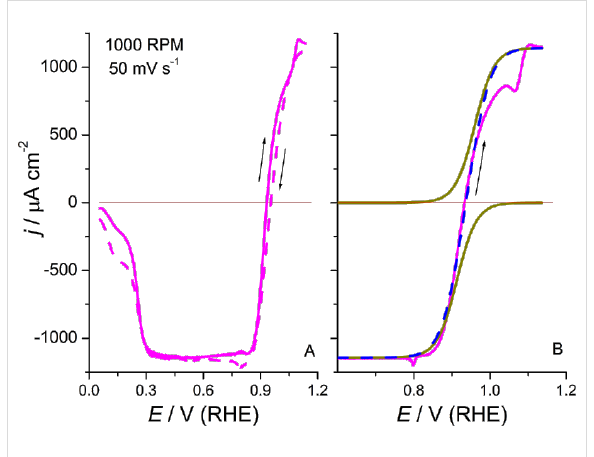
Figure 9: Hydrogen peroxide reduction and oxidation reactions on Pt(111) in 0.1 M HClO 4 + 1 mM H 2 O 2 . (A) Cyclic voltammetric profile: Positively (solid line) and negatively directed (dashed line) sweeps. (B) Adjusted curves for HPOR and HPRR (dotted lines) during the posi- tive scan. The dashed line corresponds to the sum of currents from the fitted branches and the solid line is the experimental curve after subtracting the